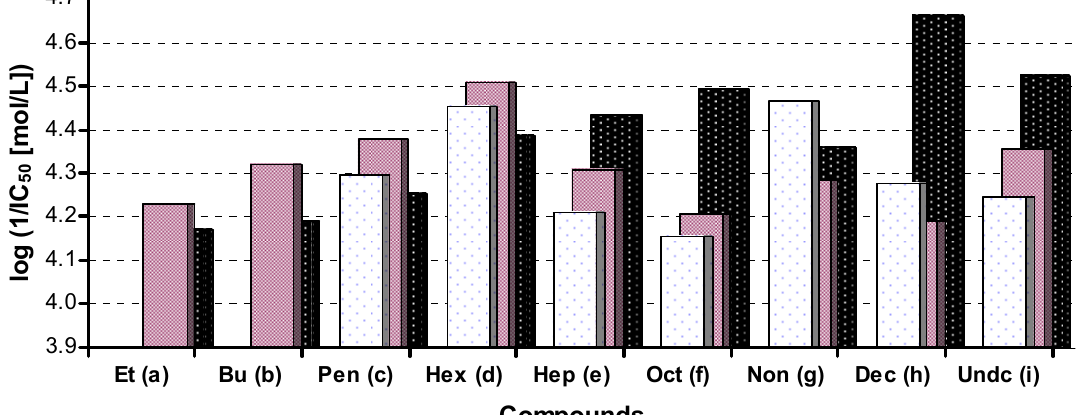
Figure 1. Dependence of AChE inhibition (log 1/IC substitution within individual Groups 1 – 3 . (Et = ethyl, Bu = butyl, Pen = pentyl, Hex = hexyl, Hep = heptyl, Oct = octyl, Non = nonyl, Dec = decyl, Undc = undecyl).